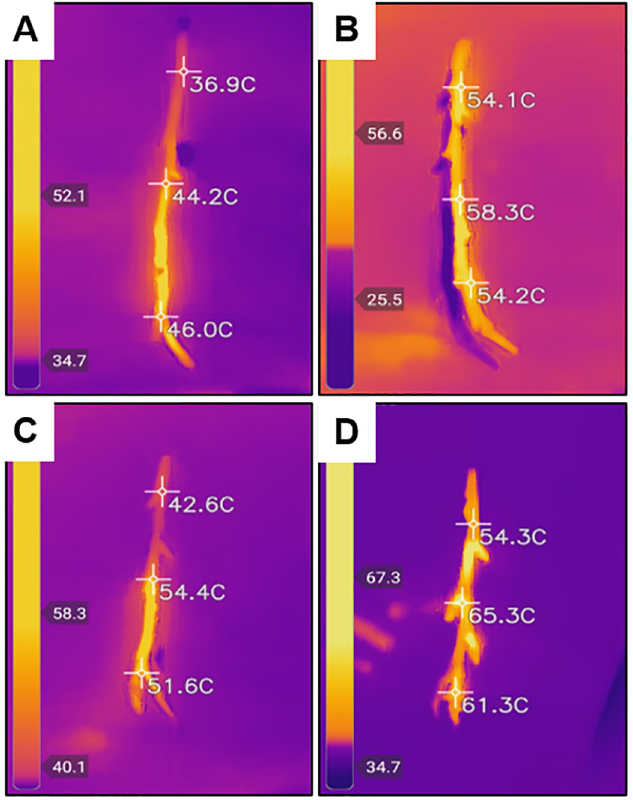
Fig 5. Thermal photos obtained following microwave irradiation treatment. Scion samples were first treated with sterile deionized water (dH 2 O) or 0.01% (w/v) multi-walled carbon nanotube (MWCNT) and then exposed to microwave radiation for 3 sec or 3 sec with scion readjustment in two iterations (6 sec total). A thermal camera was used to estimate 3-point temperature measurements of treated scions. (A) dH 2 O-treated and microwaved for 3 sec. (B) dH 2 O-treated and microwaved 3 sec in two iterations. (C) MWCNT-treated and microwaved for 3 sec. (D) MWCNT- treated and microwaved for 3 sec in two iterations.